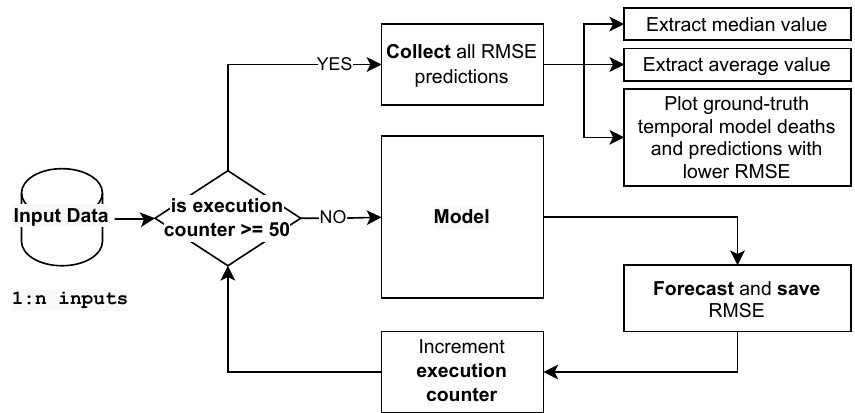
Figure 7. Workflow applied to grid search of input data